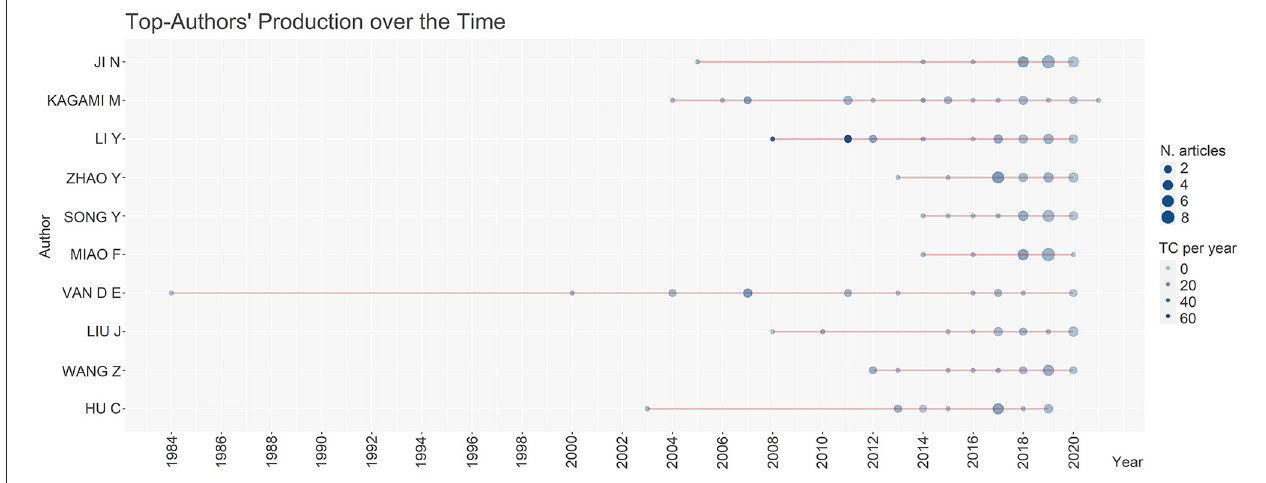
FIGURE 4 | Publication timeline of the 10 most-prolific authors on microalgae-fungi consortia.